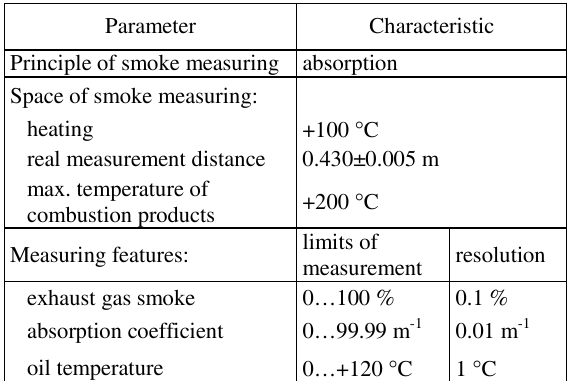
Table 2. Technical characteristics of the analyzer